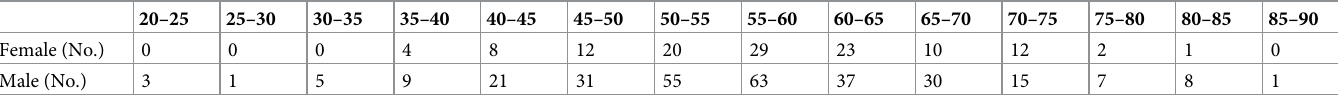
Table 1. Distribution of RRD with PVD in different age